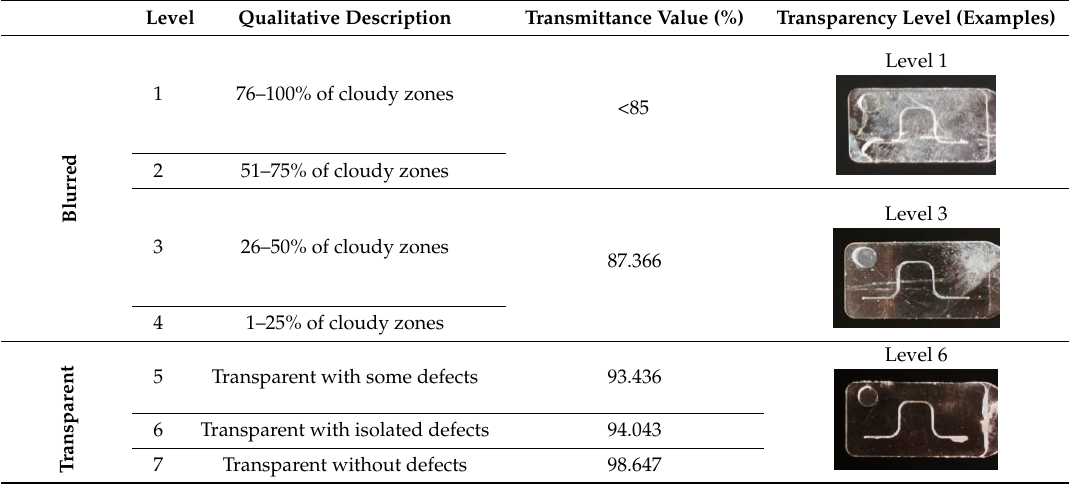
Table 2. Part transparency classification.